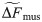
Sensitivity analysis of muscles forces using ΔF~mus.Asterisk: shift in AP direction. Square: shift in CC direction. Circle: shift in LM direction.